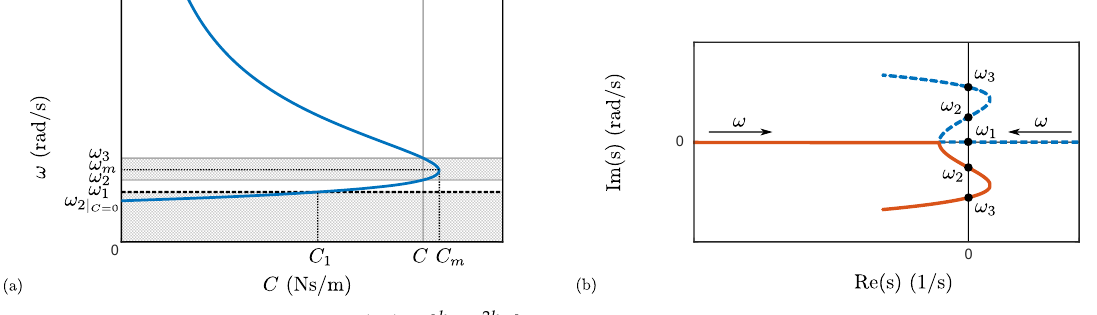
] : ( a ) evolution of the spin speeds ω ; 3 k ∞ 2 4